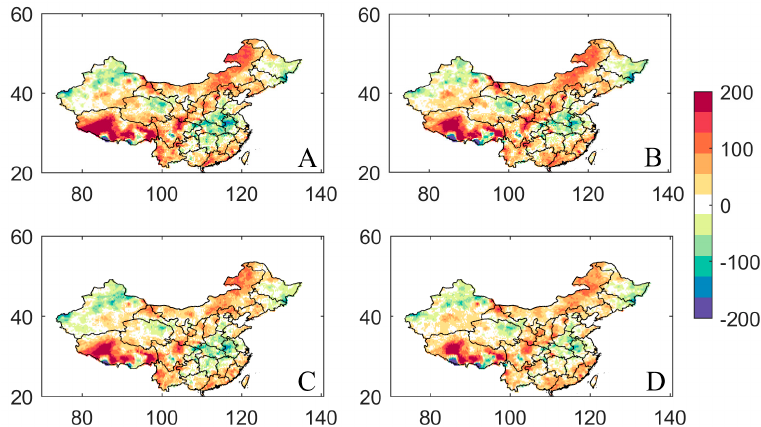
Figure 3. Changes in the frequency (days) of compound droughts and hot extremes for the period